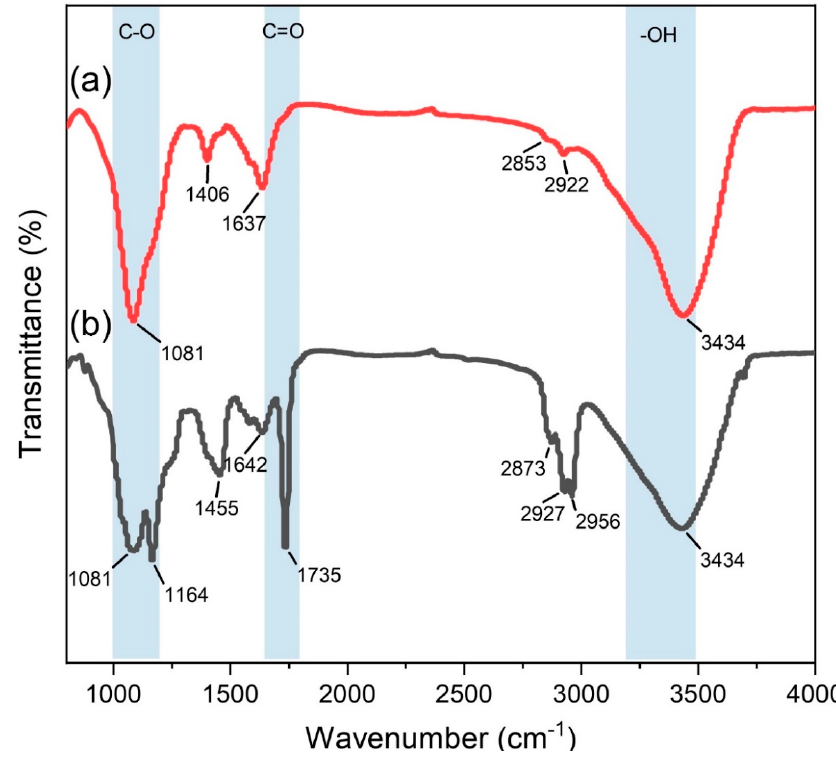
Figure 2. FTIR spectra of ( a ) CNT and ( b ) C-CNT. XPS analysis was used to study the differences between elements and functional groups on the surface of CNT and C-CNT. Figure 3 presents C1s XPS spectra and XPS survey scans of CNT and C-CNT. The C1s peak was deconvoluted by XPS-PEAK software and divided according to four binding energy positions in order to analyze the content of different functional groups, as shown below: Sp 2 C (284.8 eV), Sp 3 C (285.1 eV), –C–O– (286.2 eV) and –CO–O– (290.1 eV). The content of the functional groups and element con- tent of CNT and C-CNT were summarized in Table 1 and Table 2, respectively. More O atom content was observed in C-CNT, with a twofold increase in the O/C ratio compared to CNT, implying that C-CNT had more oxygen-containing functional groups on the sur- face. Compared with CNT, the content of –C–O– of C-CNT increased from 7.04% to 11.74%, and the content of –CO–O– also increased, which indicated that C-CNT had more –COOH and –OH functional groups, which was also in agreement with the results of FTIR analysis.